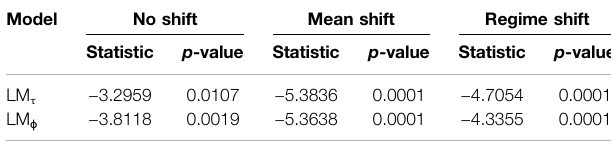
TABLE 3 | Cross-sectional dependence test results. Variable